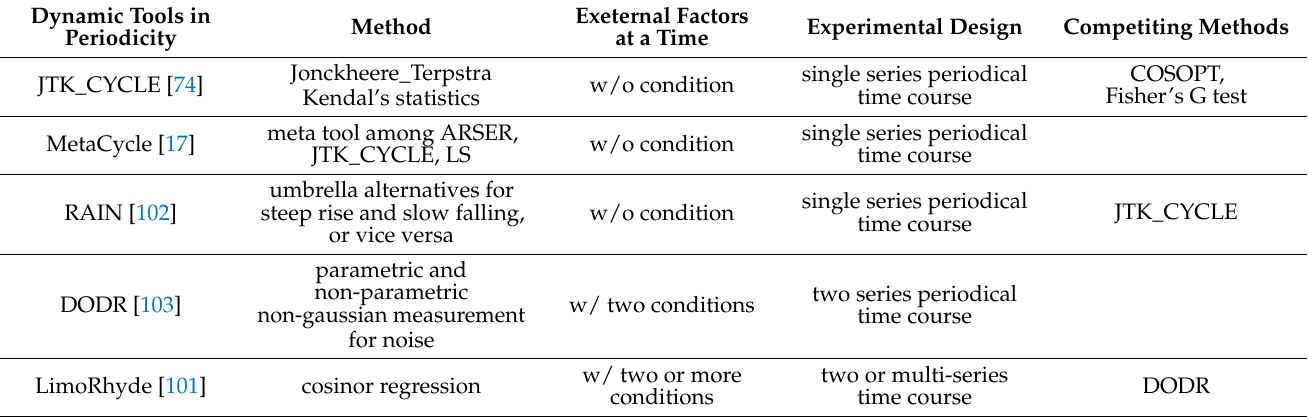
Table 2. Dynamic gene-by-gene (gene-wise) testing tools for periodical time course RNA-Seq data. Dynamic Tools in Periodicity